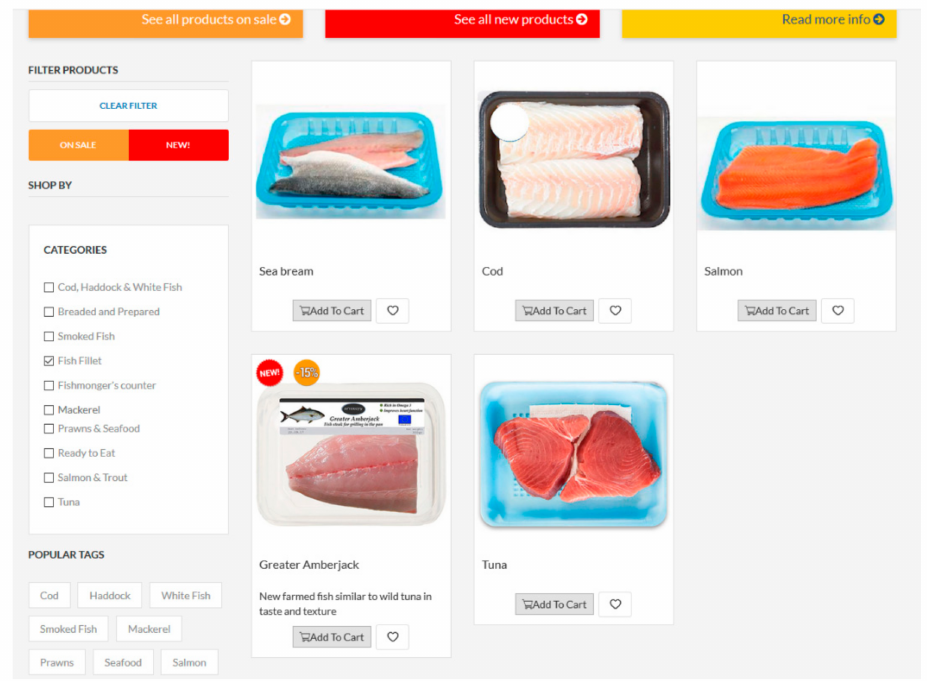
Figure 1. Screenshot of page 2 of the online store. Copyright: Hellenic Research House,